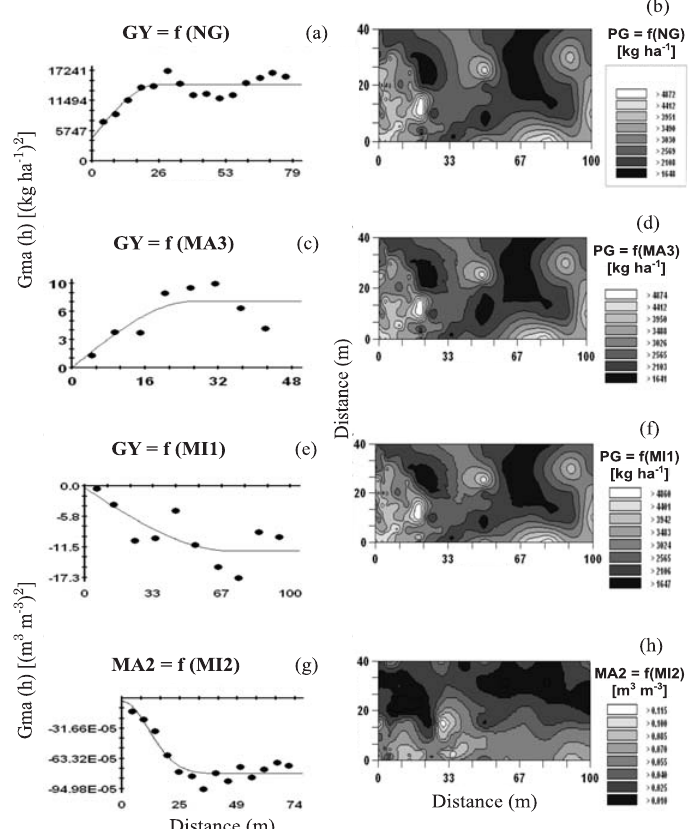
Figure 2. Co-kriging maps of the soybean yield attributes, macroporosity and microporosity of a dystroferric Red Latosol. GY: soybean grain yield; NG: number of grains per plant; MA and MI, from 1 to 3, respectively, are the macroporosity and microporosity of the evaluated soil